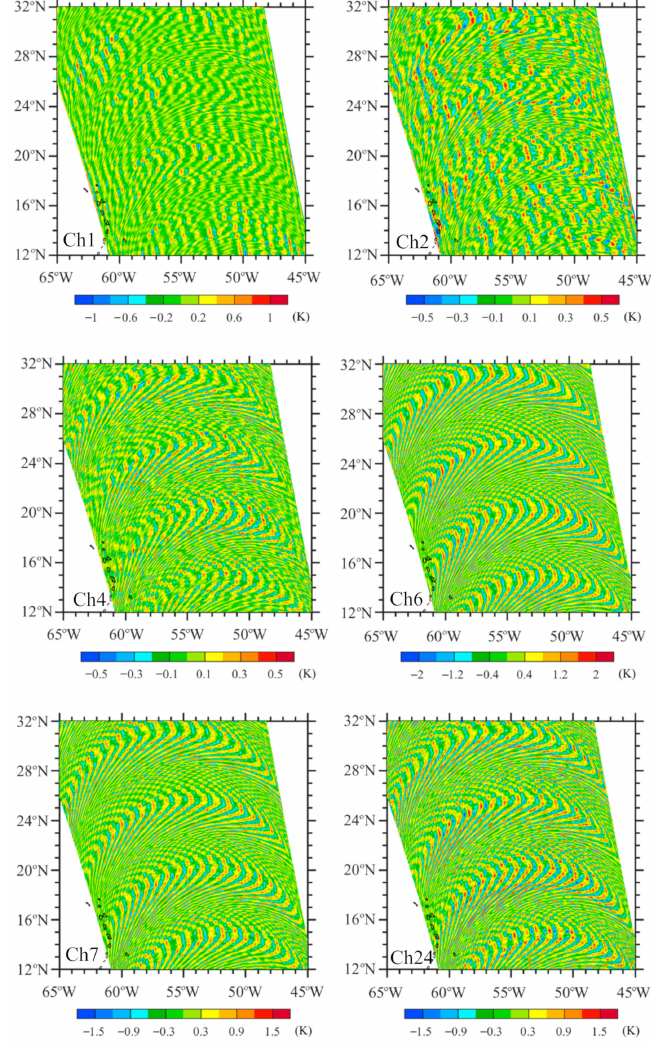
Figure 11. Detected noise at channels 1, 2, 4, 6–7, and